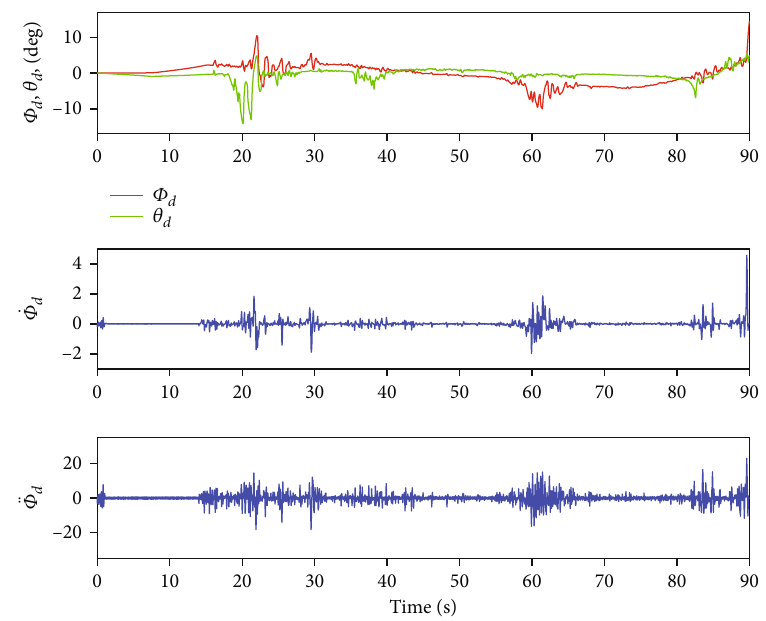
_ Φ € Φ Þ and pitch angle ð θ , , d d d